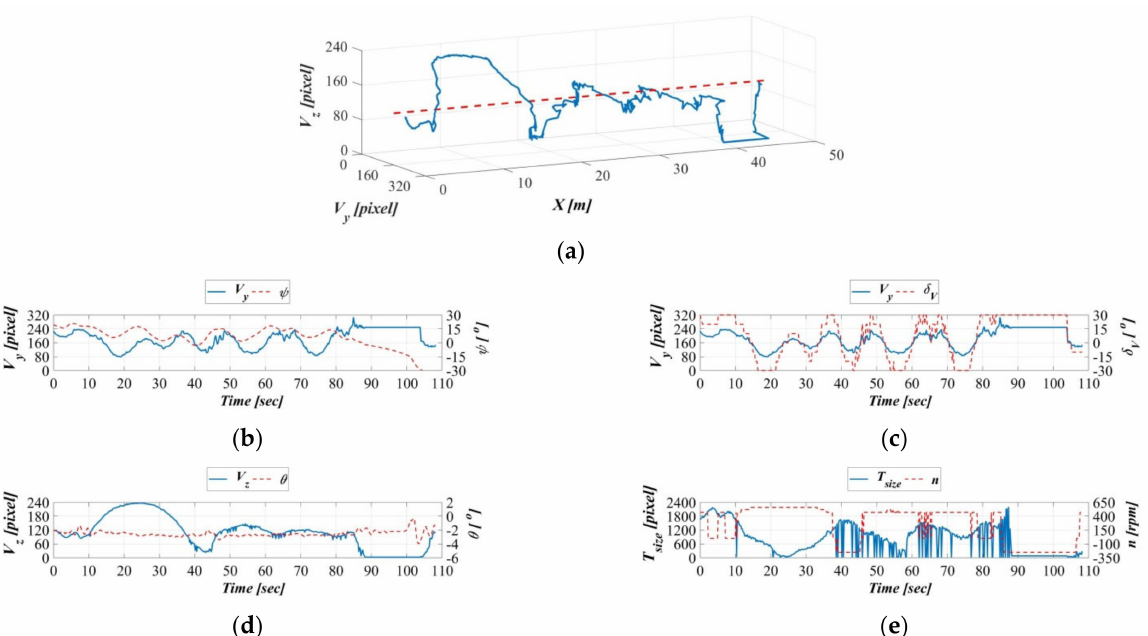
Figure 18. Dynamic guidance experiment with a towing speed of 0.6 m/s. ( a ) Displacement trajectory on the image coordinates, ( b ) time series of the image coordinate Y − axis and AUV yaw angle, ( c ) time series of image coordinate Y − axis and AUV vertical rudder, ( d ) time series of the image coordinate Z − axis and the AUV vertical rudder, and ( e ) time series of the image coordinate surface area and the AUV propeller revolution